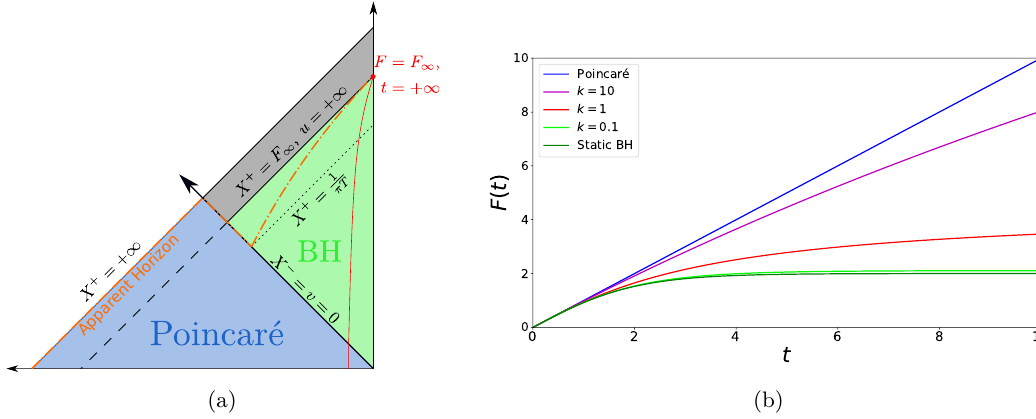
Figure 1 . (a) Evaporating black hole setup. Starting in the Poincaré patch, we send in a pulse at t = 0 to form a black hole. If the black hole were static, the ( u, v ) coordinates could only describe up to the would-be horizon X + = 1 . In the evaporating case, these coordinates describe the patch πT up to F . The red wiggly curve represents the holographic boundary curve. The apparent horizon ∞ is denoted in dashed orange. (b) Reparametrisation profiles for the different scenarios and T = 1 The time reparametrisation of the evaporating black hole interpolates between the eternal black hole and the Poincaré patch for increasing evaporation rate k